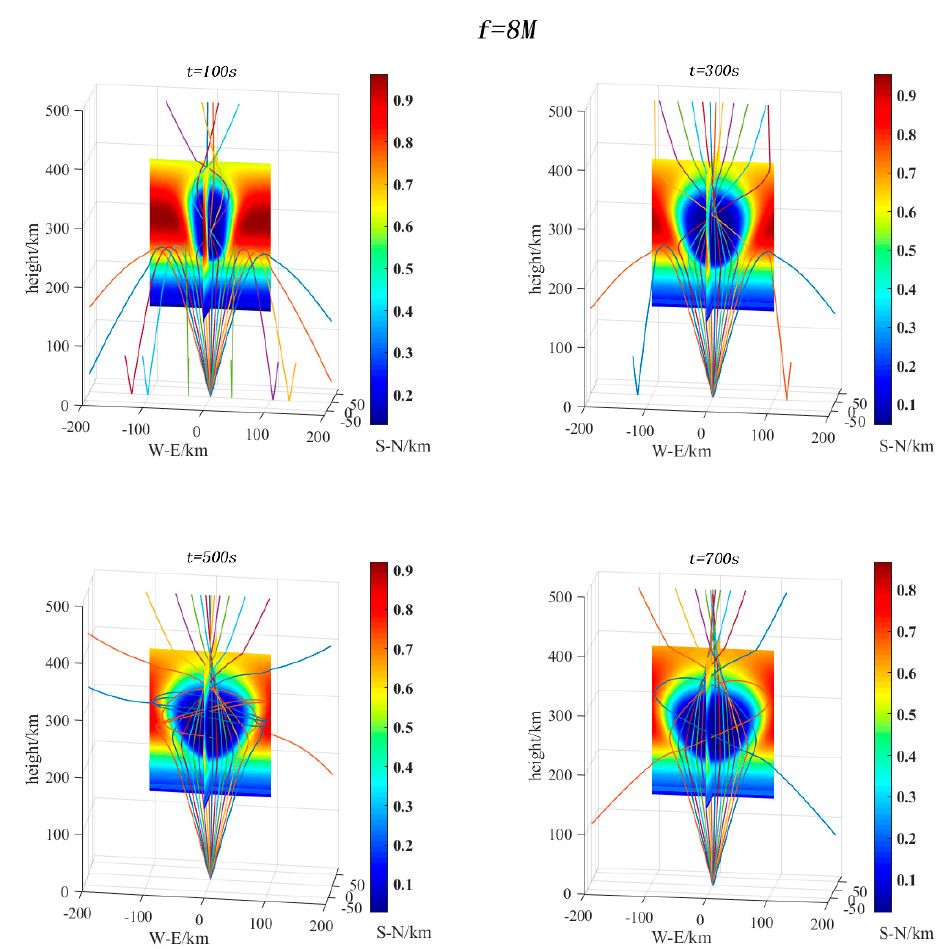
Figure 8. The 3-D ray tracing simulation of 8 MHz shortwave echo path after CO 2 release of 100 s, 300 s, 500 s and 700 s (electron density unit: 10 6 cm − 3 ).